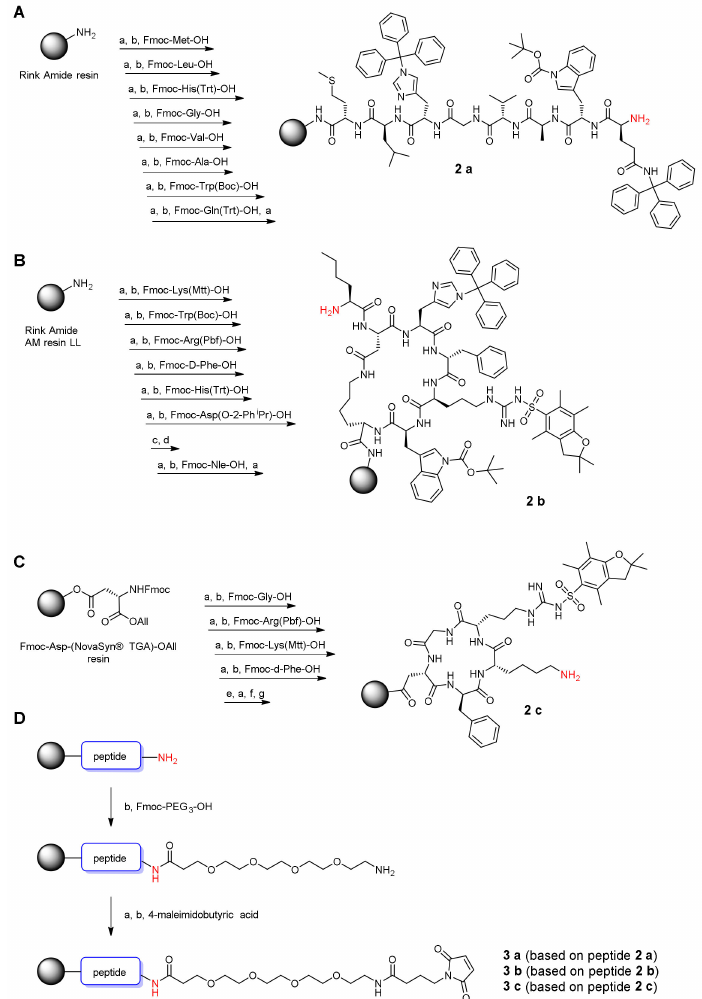
Scheme 1. Solid-phase synthesis of peptide units 3 a-c : ( A ) Synthesis of resin-bound